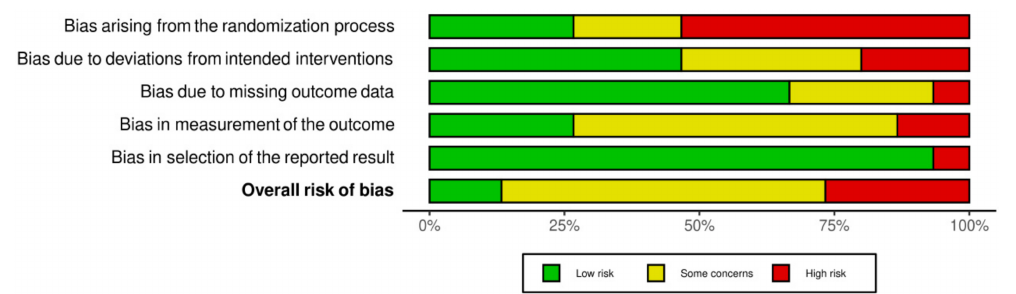
Figure 3. Overall presentation of the domains of risk among the